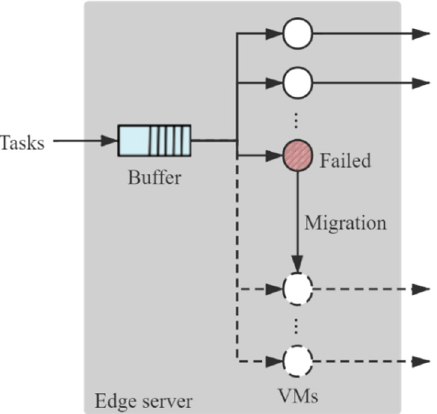
Figure 2. Queueing model of an edge server. The dash-lined circles indicate backup VMs.